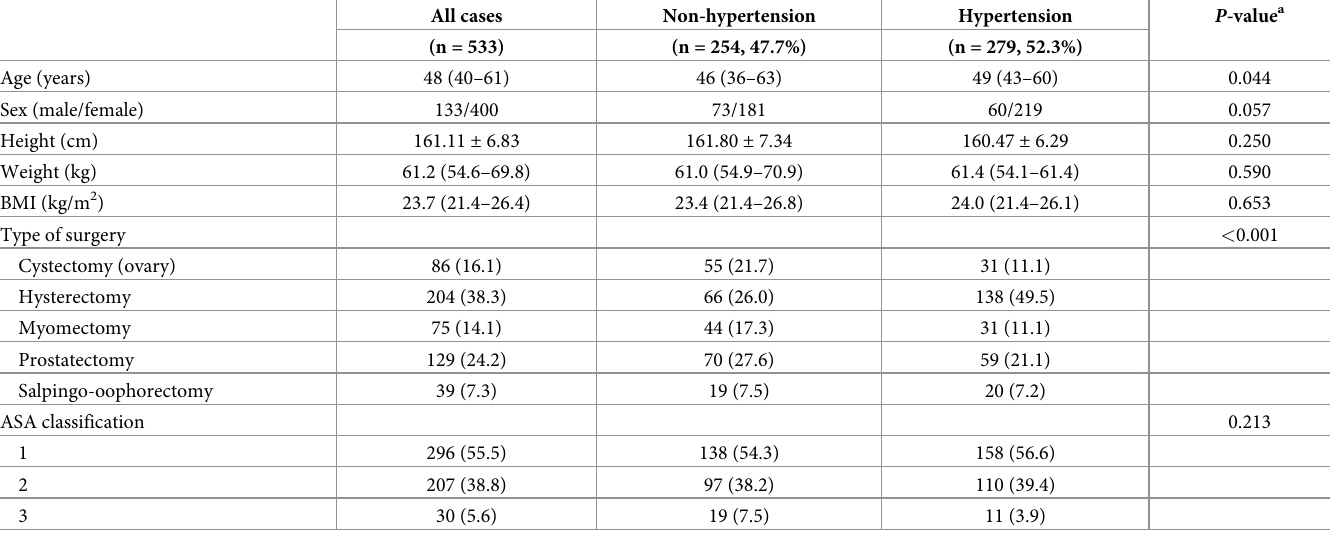
Table 1. Patient demographics based on non-hypertension and hypertension group classification.